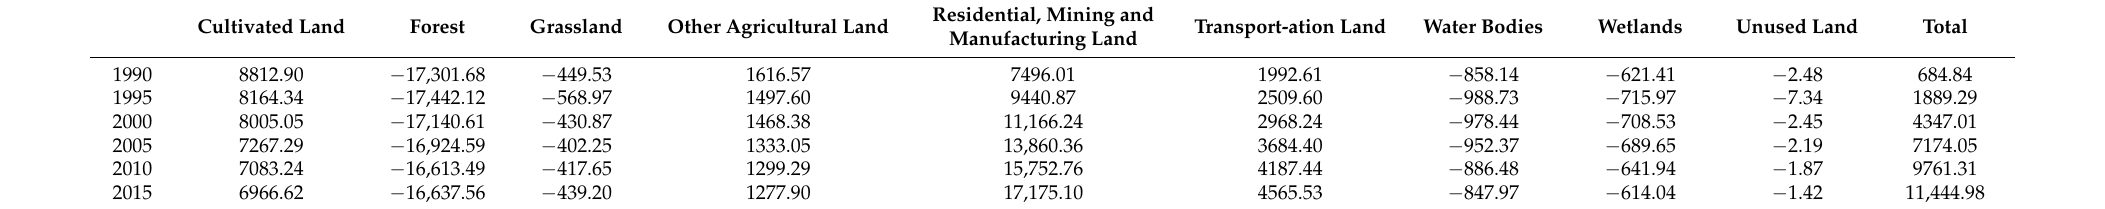
Table 4. Carbon emissions from different land-use types in the PRD (10 4 t